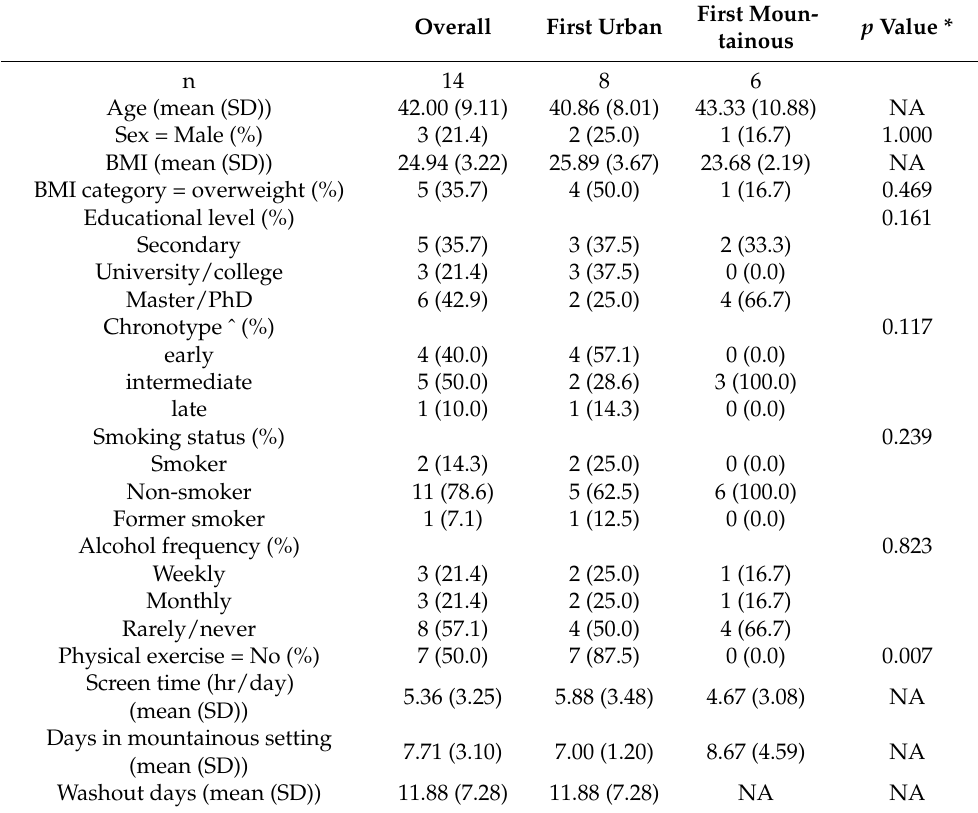
Table 1. Demographics and baseline characteristics of the study population (overall, and by